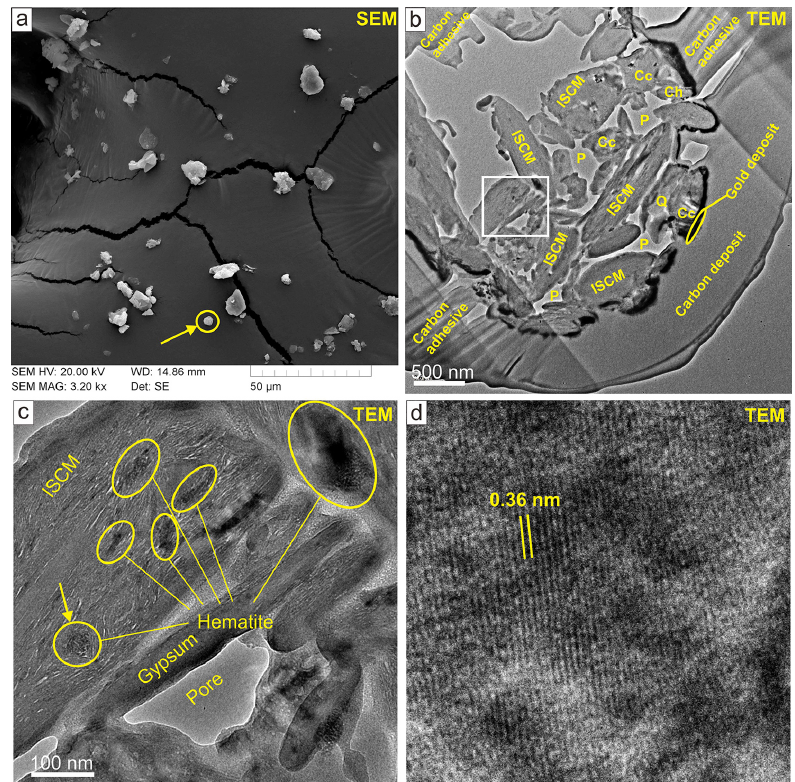
Figure 1. Example internal structure and mineral distribution in Asian dust particle. Panel (a) is an SEM image showing a dust particle of 3.8µm in diameter (arrow) processed with focused ion beam to prepare a thin slice for TEM analysis. Panel (b) is a TEM image of the slice showing mineral grains and interstitial pores. Cc = calcite, Ch = chlorite, ISCM = illite-smectite series clay minerals, P = pore, Q = quartz. Gold deposition was applied for electrical conduction for SEM observation. Carbon was deposited before focused ion beam process. Panel (c) is a magnified image from the square in Panel (b) showing the submicron hematite grains enclosed in the illite-smectite series clay minerals. Panel (d) is a lattice fringe image of hematite indicated as arrow in Panel (c)